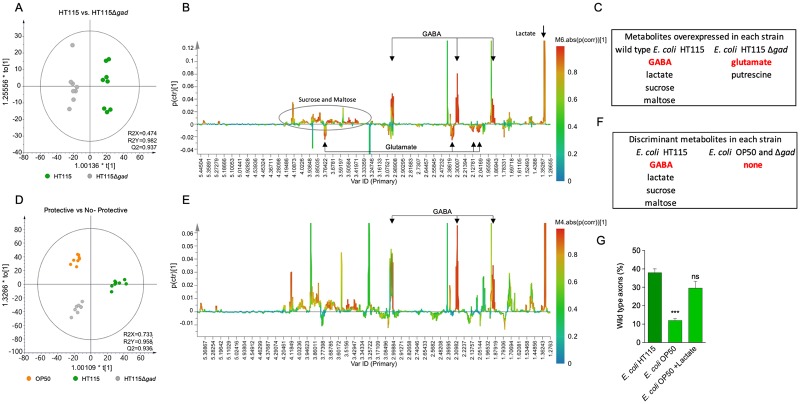
Metabolomics analysis of neuroprotective and nonprotective bacteria.(A–D) OPLS-DA score plot of protective E. coli HT115 wild type (blue) and nonprotective E. coli HT115Δgad (light gray) (A) and E. coli HT115 wild type (blue) and nonprotective E. coli HT115Δgad (light gray) and OP50 (dark gray) (D). (B–E) OPLS-DA S-line plots with pairwise comparison of data from NMR spectra obtained comparing the E. coli HT115 strain against HT115 Δgad (B) and the E. coli HT115 strain against HT115 Δgad and E. coli OP50 (E). Colors are associated with the correlation of metabolites characterizing the 1H NMR data for the class of interest, with the scale shown on the right-hand side of the plot. In (B), GABA and glutamate signals are shown. (C–F) Tables indicate which metabolites are differentially expressed in each strain. (G) Percentage of wild-type axons in mec-4d animals fed with E. coli OP50 supplemented with lactate. ***P < 0.001; ns. The underlying numerical data for the figure panels can be found in S1 and S2 Tables (A to F) and S1 Dataset (G). Statistical analysis can be found in S2 Dataset. GABA, γ-aminobutyric acid; gad, glutamate decarboxylase enzyme gene; mec-4d, mechanosensory abnormality protein 4; NMR, nuclear magnetic resonance; ns, not significant; OPLS-DA, orthogonal projections to latent structures discriminant analysis.